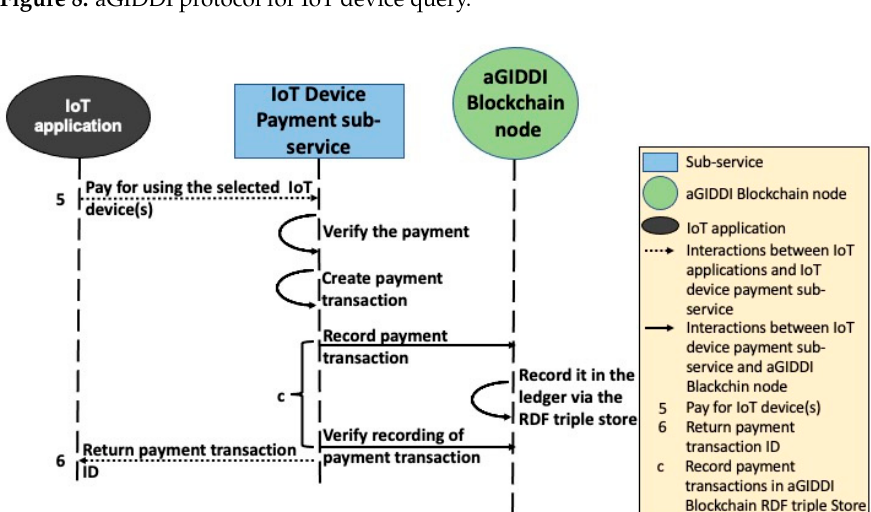
Figure 9. aGIDDI protocol for IoT device payment.